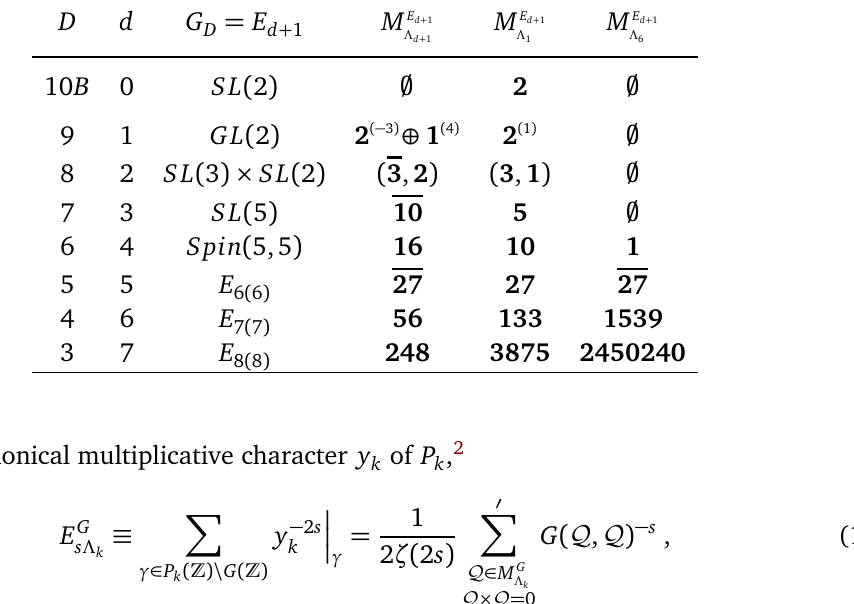
Table 1: U-duality group, particle multiplet ( Λ constraints on the particle and string multiplets are in Λ